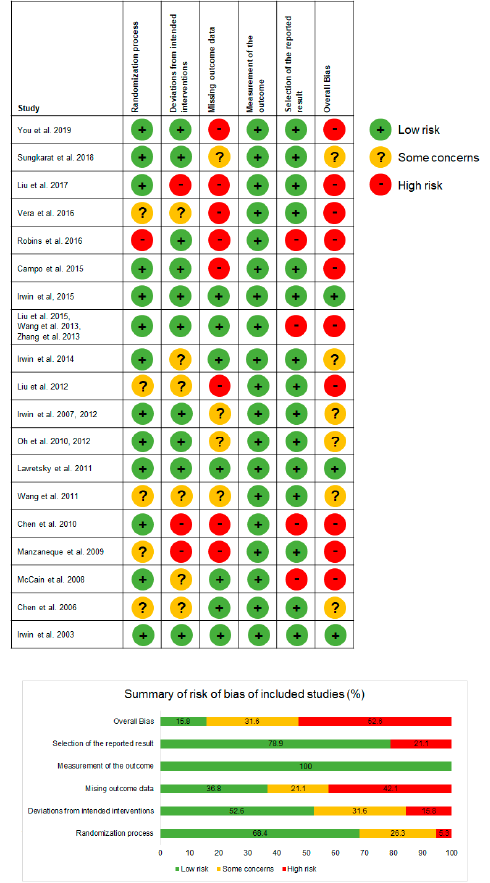
Figure 7. Risk of bias assessment.